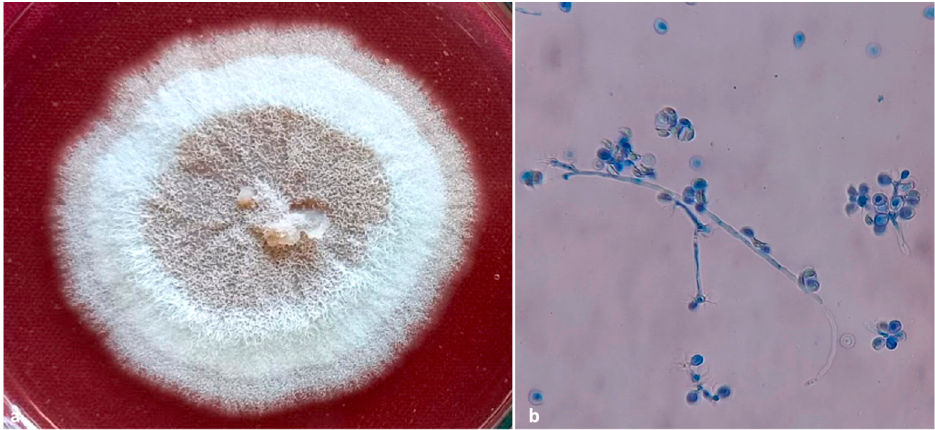
Figure 8. ( a ) culture plate of Ambrosiozyma monospora ; ( b ) presence of globose asci in clusters at nodes of the ascophoric